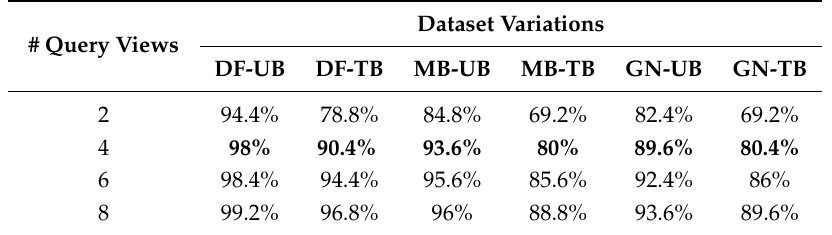
Table 1. Average hit-rate of the HBR method on the different variations in the SOM